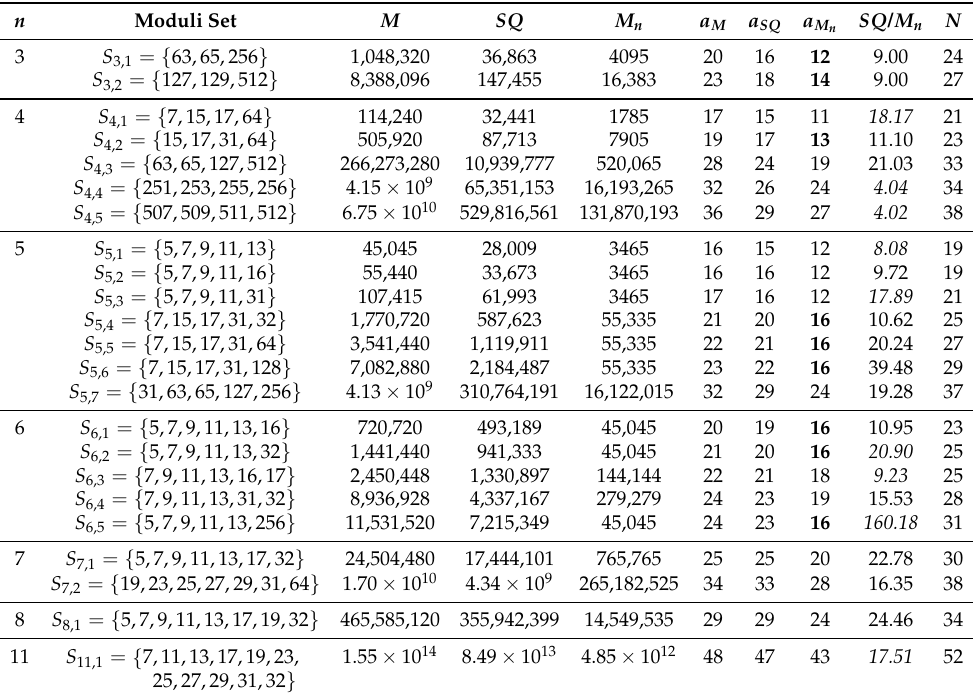
Table 2. Operand sizes of the MOMAs required to implement comparators for various RNS moduli sets. n Moduli Set M